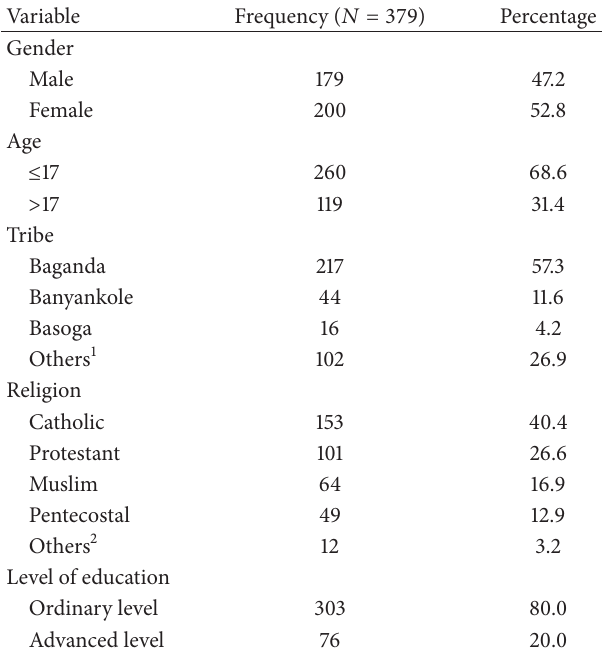
Table 1: Sociodemographic characteristics of study